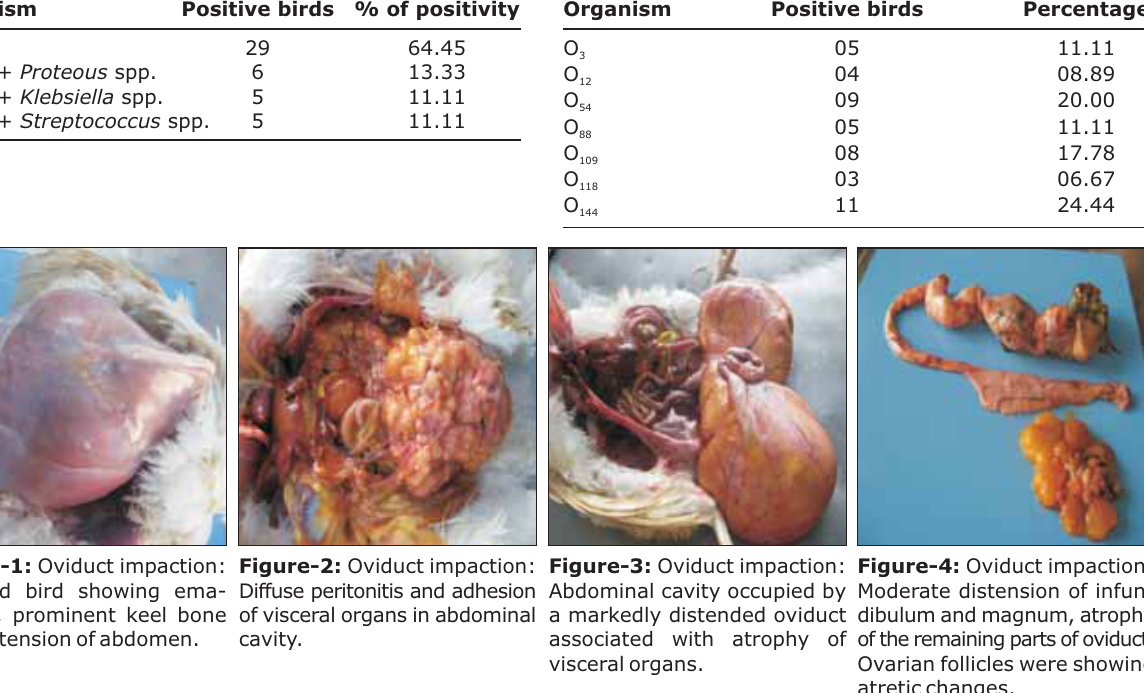
E.coli Table-3: Frequency pattern of serotypes isolated from impacted oviduct of layer chicken.